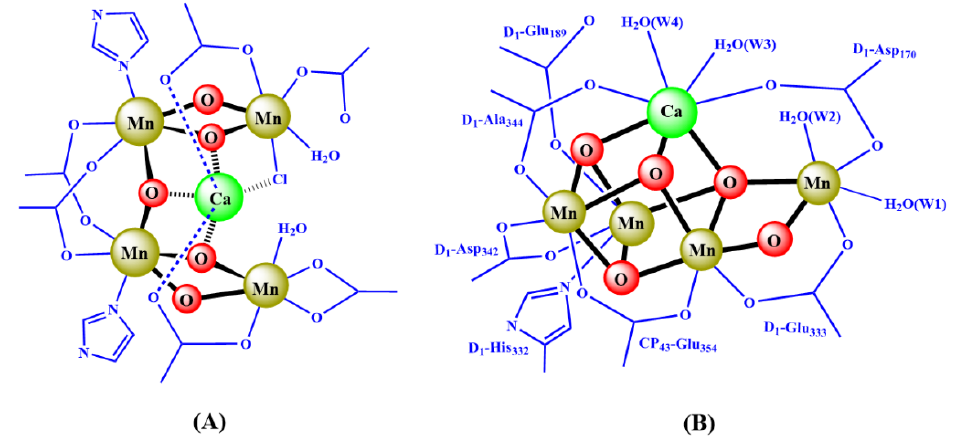
Figure 2. Scheme for the structural model [37,38] ( A ) and structure of the OEC [39] ( B ).